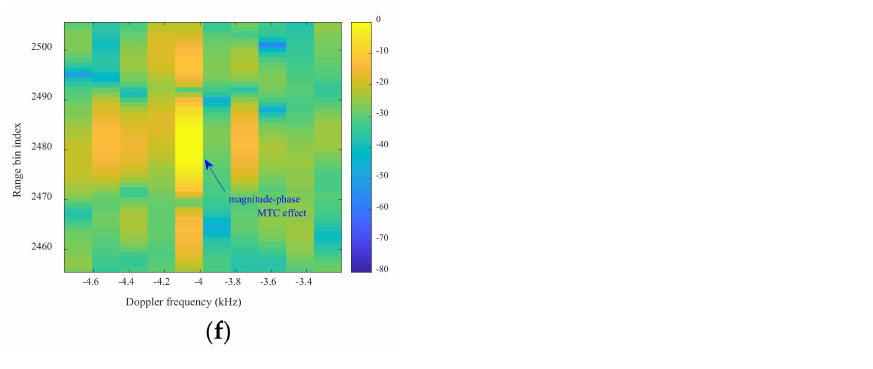
Figure 6. Experiment results of the sub-band STAP. ( a ) R-D spectrum of measured data in the sum channel with full-band. ( b ) Output R-D spectrum of the full-band STAP. ( c ) Partial enlargement view of ( b ). ( d ) R-D spectrum of measured data in the sum channel with sub-band. ( e ) Output R-D spectrum of the sub-band STAP. ( f ) Partial enlargement view of ( e ).